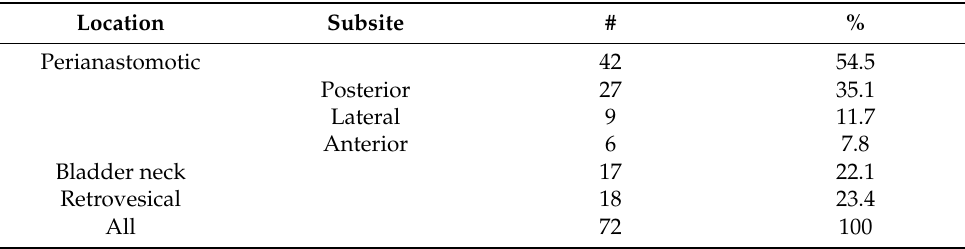
Table 2. Location of the lesions at mpMR.